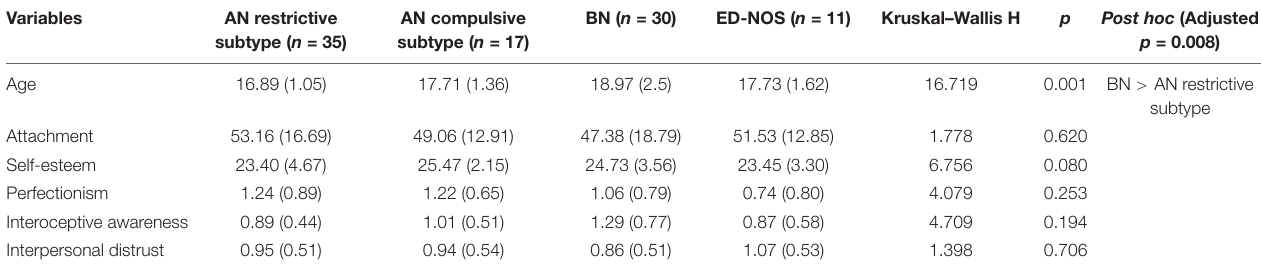
TABLE 2 | Group differences in demographic characteristics and main study